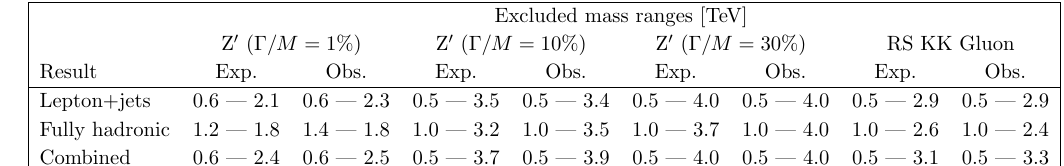
Figure 7 . Expected and observed limits presented as a function of width, for M Z 0 = 1 ; 2, 3, 4 TeV. The corresponding theoretical prediction as a function of width is shown as a dot-dashed curve in each case.